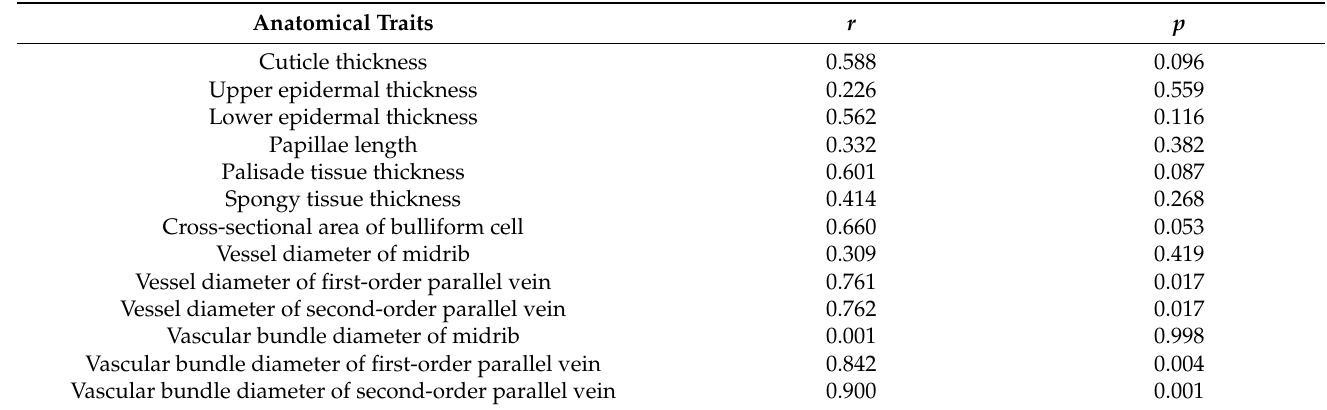
Table 2. Correlations between plant biomass and anatomical traits of Phyllostachys glauca in the limestone